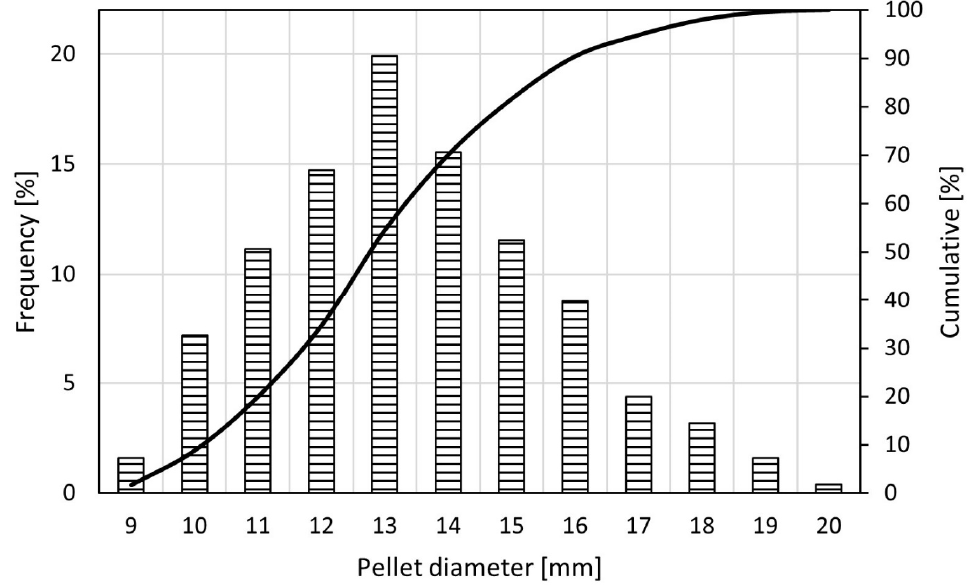
Figure 1. Pellet size distribution of 251 randomly selected pellets.